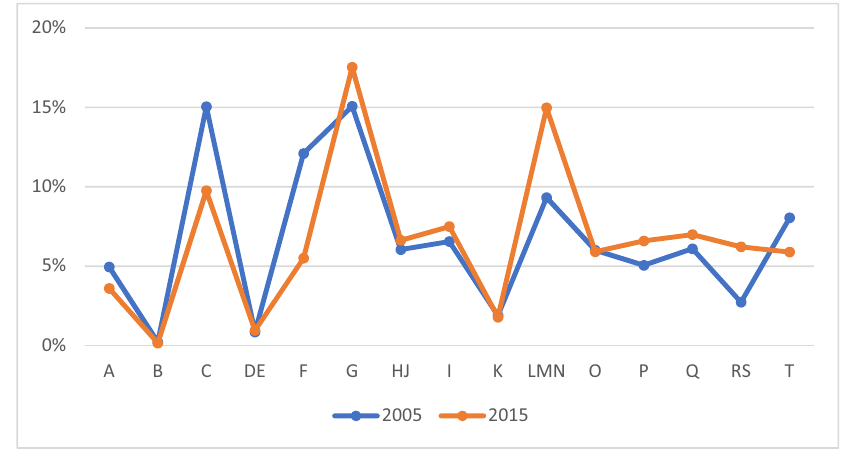
Figure 1: Total employment distribution ( percentages ) . Source: Compiled by author based on the IOTs for 2005